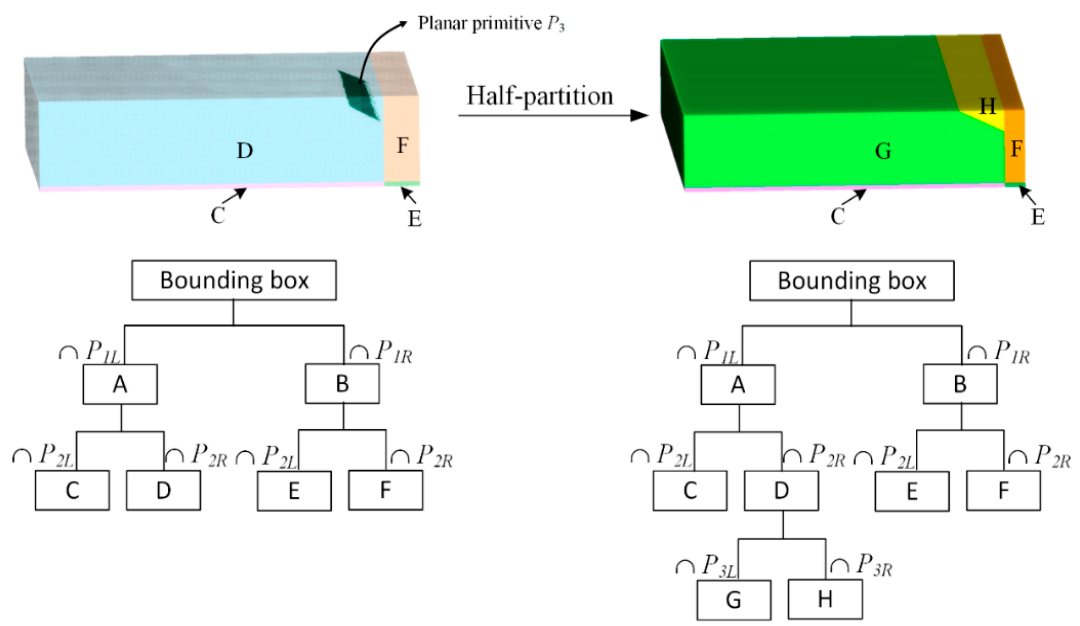
Figure 4. Generation of the partitioning CSG-BRep tree with a half-partition.